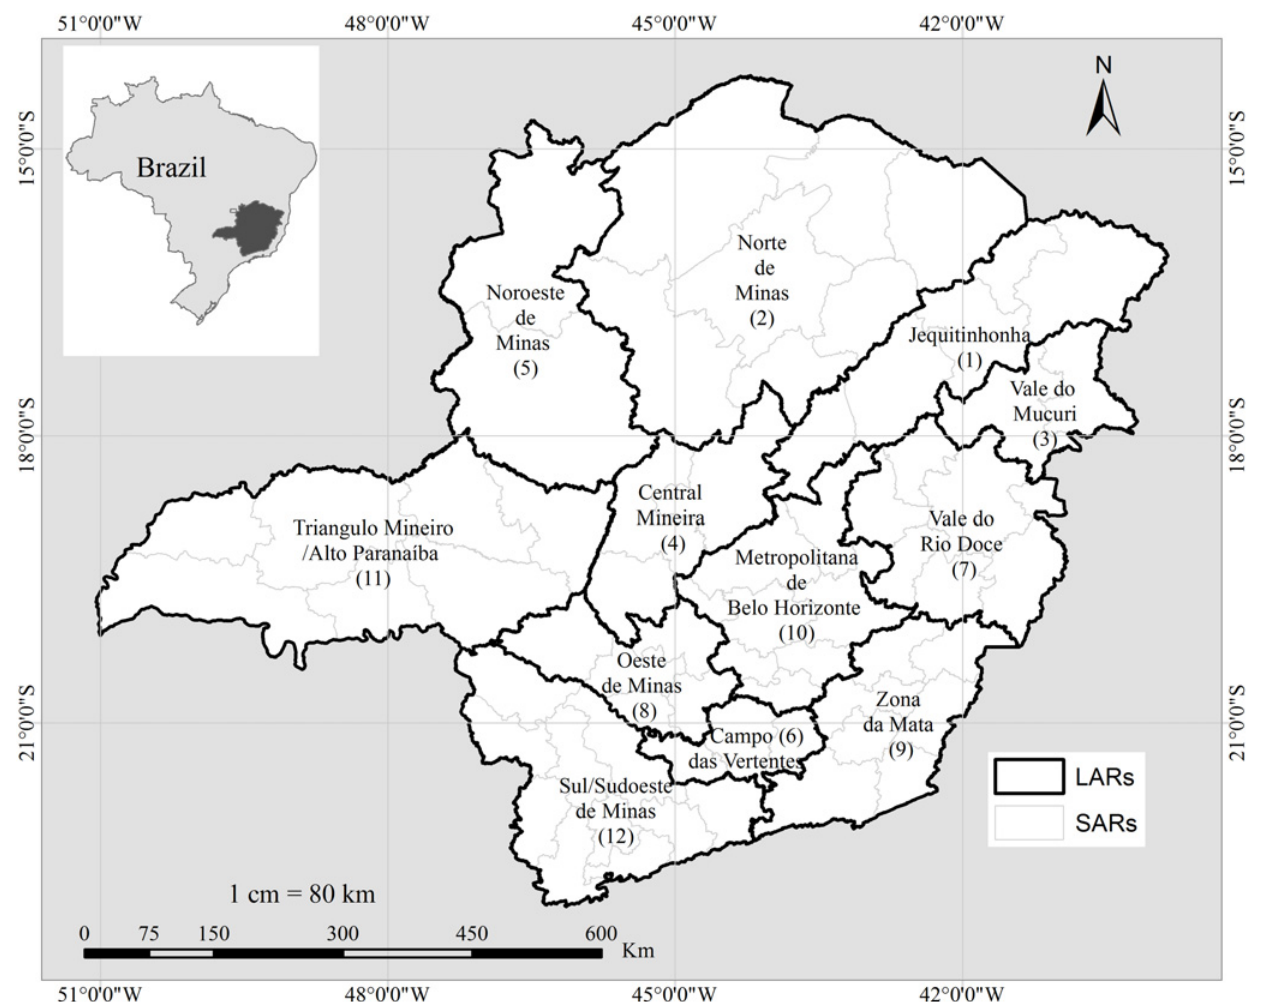
Fig 1. Minas Gerais State, regional geopolitical divisions and location in